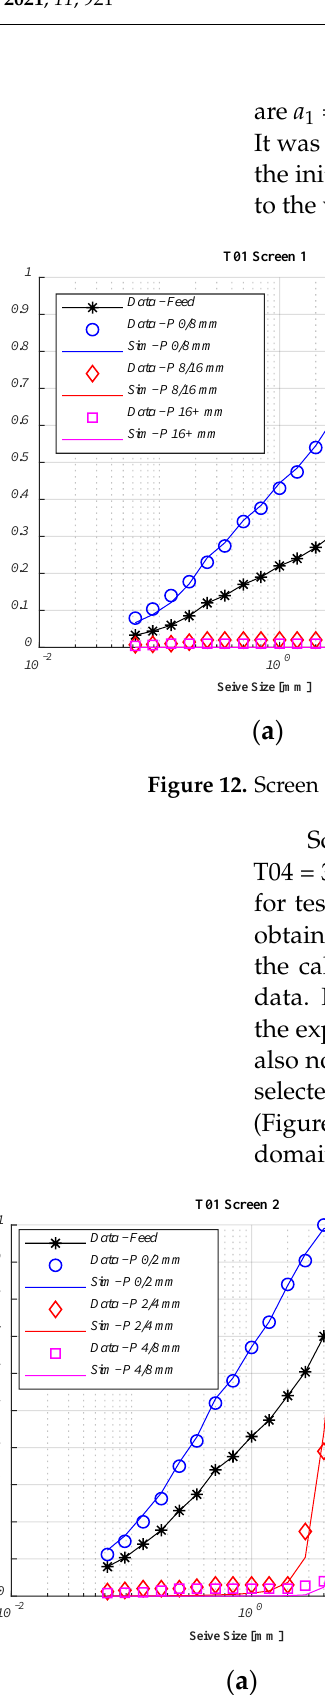
Figure 13. Screen 2 calibration results for ( a ) T01 and ( b ) T04 in the cumulative domain.